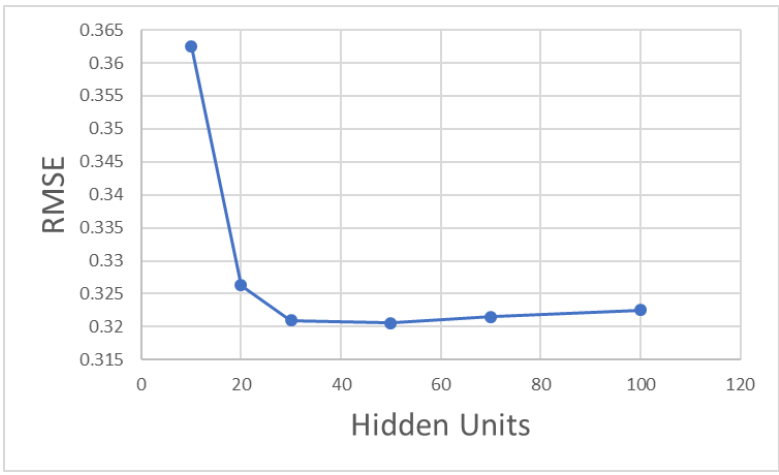
Figure 8. Effect of different hidden units on model accuracy.